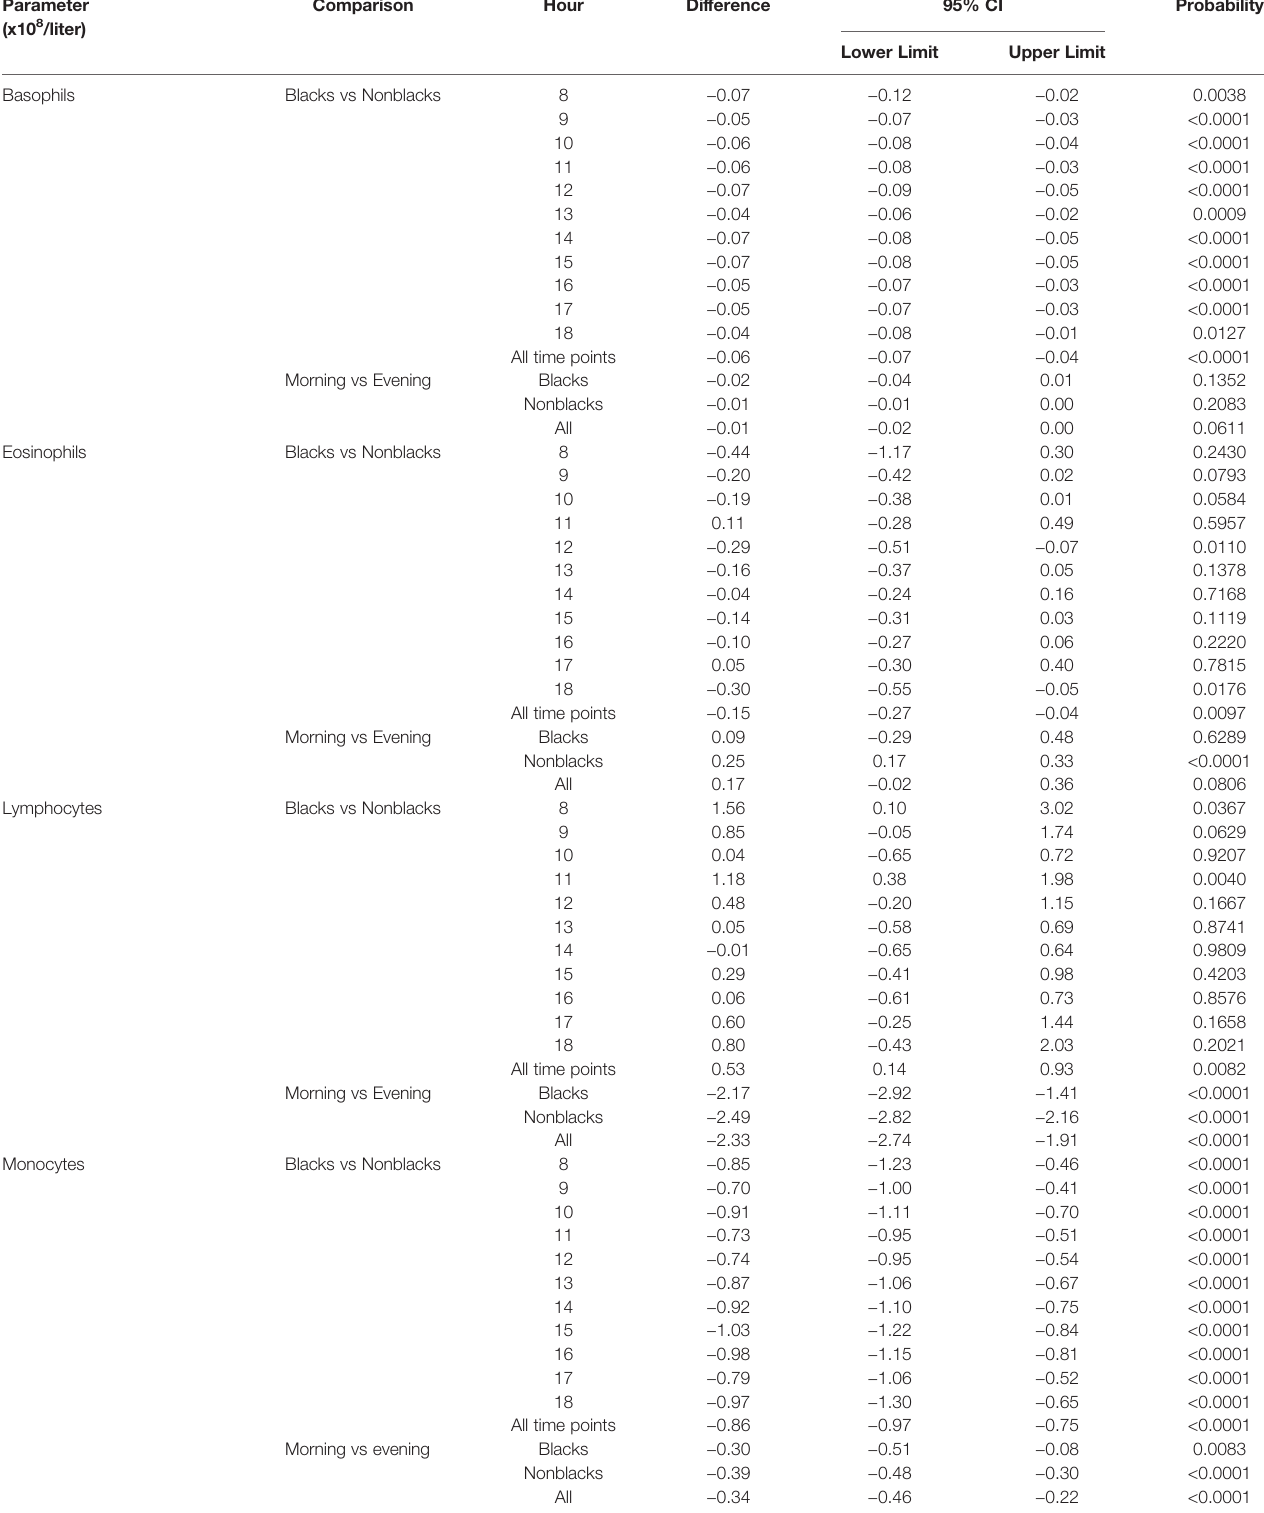
TABLE 4 | Generalised estimating equation (GEE) model analysis of haematological parameters [Basophils, Eosinophils, Lymphocytes, Monocytes, Neutrophils, and white blood cell (WBC)]: between and within group comparison. Parameter Comparison Hour Difference (x10 8 /liter)